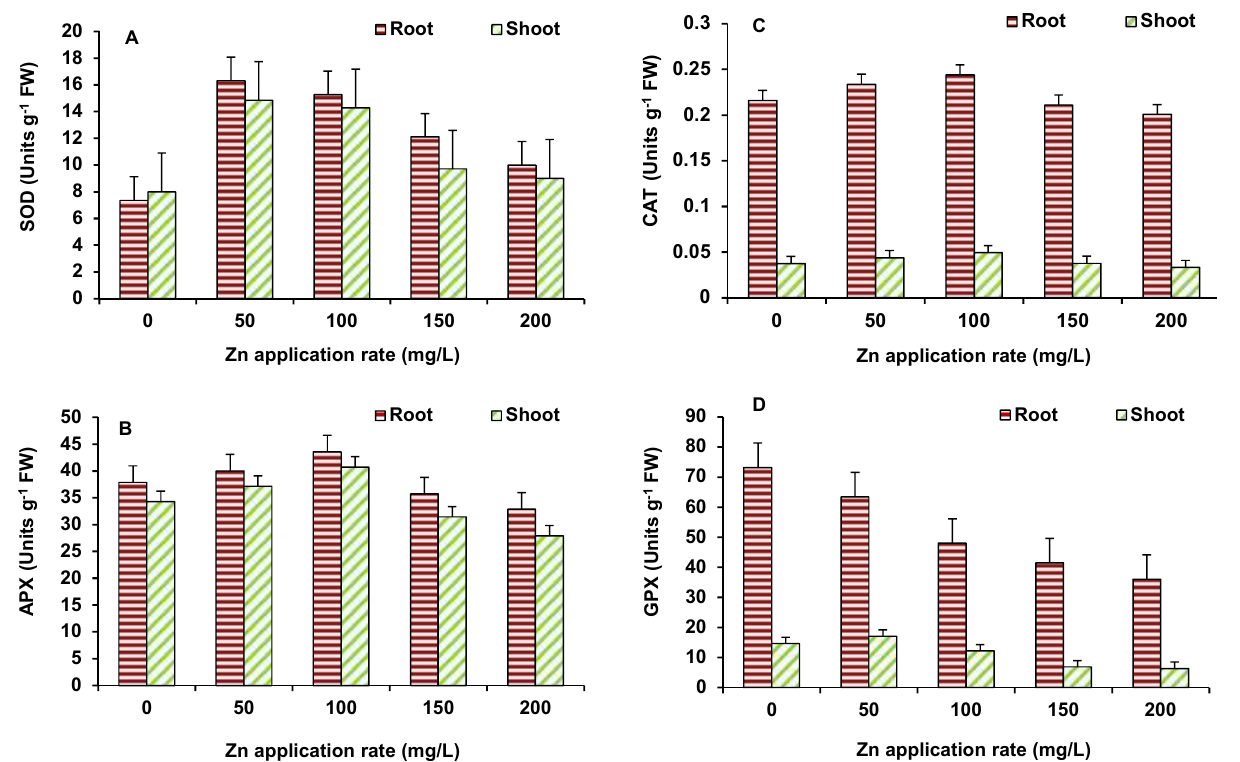
Figure 8. Effect of ZnO NPs treatment on activity of SOD ( A ), APX ( B ), CAT ( C ), and GPX ( D ) of wheat. Values are means of four replicates. Error bars indicate the least significant value (LSD) at p ≤ 0.05 among the treatments.